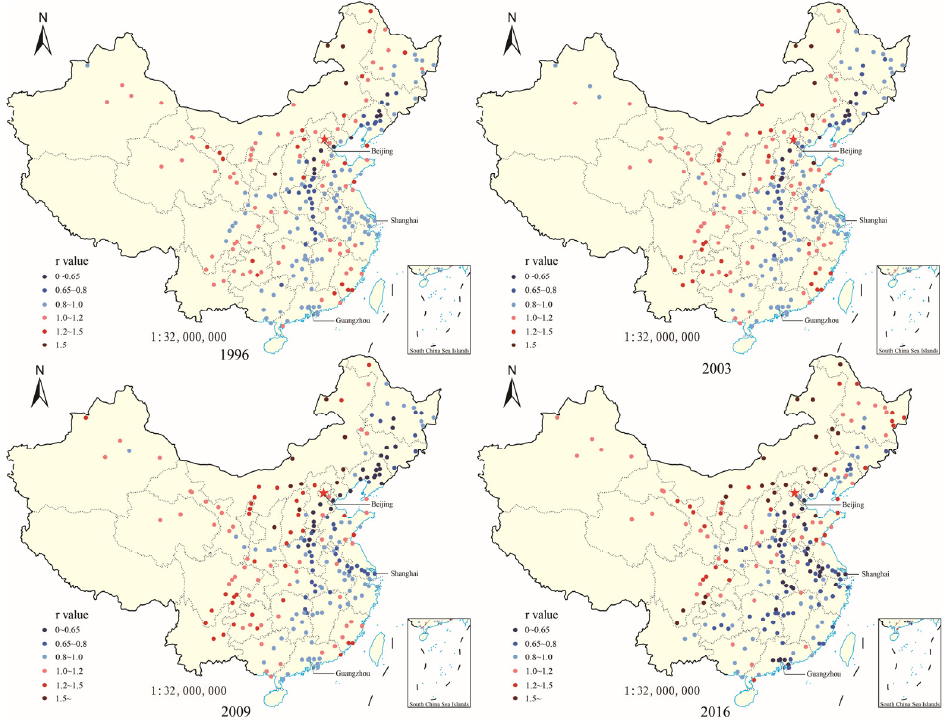
Figure 8. Changes in STCP for cities in China from 1996 to 2016. Table 3. Travel times and STCP values for cities in northeast